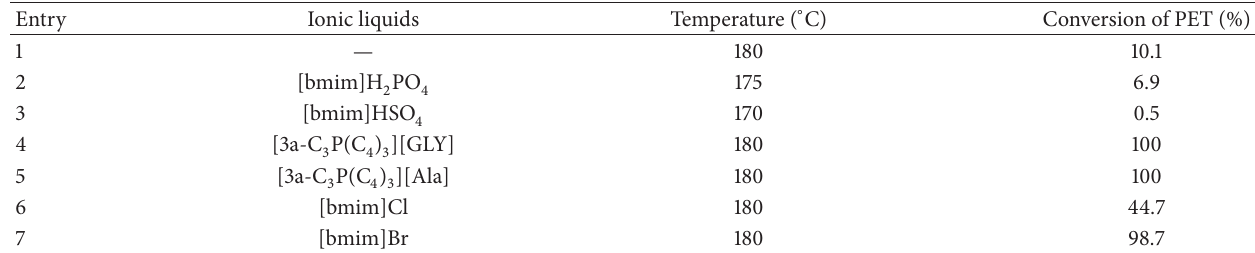
Table 1: Catalytic effect of different ionic liquids on the PET glycolysis [9].